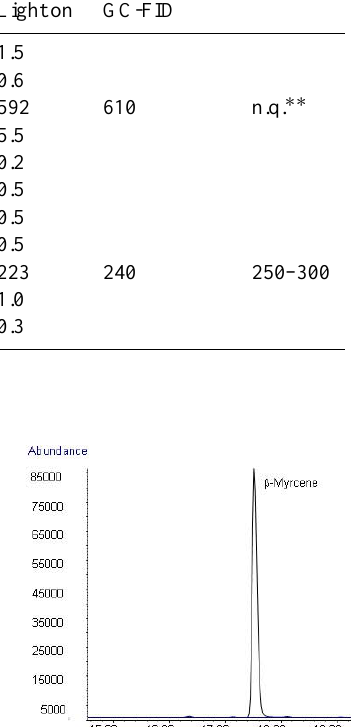
Table 4. Average gas exchange rates (ngm − 2 s − 1 ) of monoterpenes from the emission of potted individual of Q. ilex obtained with SPME with DVB-PDMS fibre at 20 min sampling during light and dark conditions compared to those recorded by solid sorbent GC-FID and zNose. SPME SPME Solid sorbent zNose